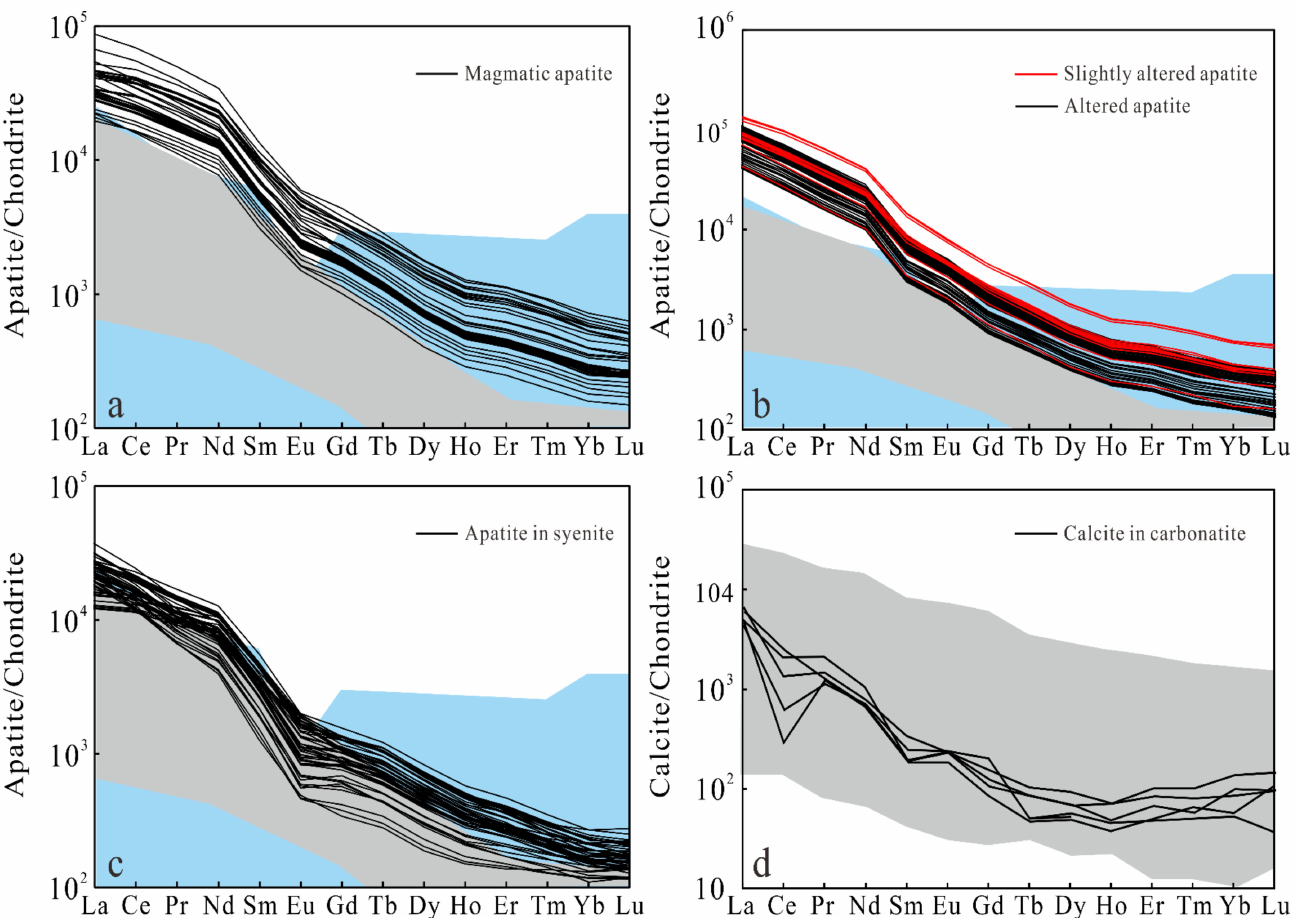
Figure 9. Chondrite-normalized REE patterns of apatite from magnetite-apatite-enriched rocks and syenites ( a – c ) and calcite from carbonatite ( d ). Normalization values were adopted from Sun and McDonough [40]. Previously reported apatite data from magnetite-apatite-enriched rocks and carbonatite are presented in blue and gray in ( a – c ) for comparison [25,27,34,43,44], and calcite data from carbonatite are presented in gray in ( d ) for comparison